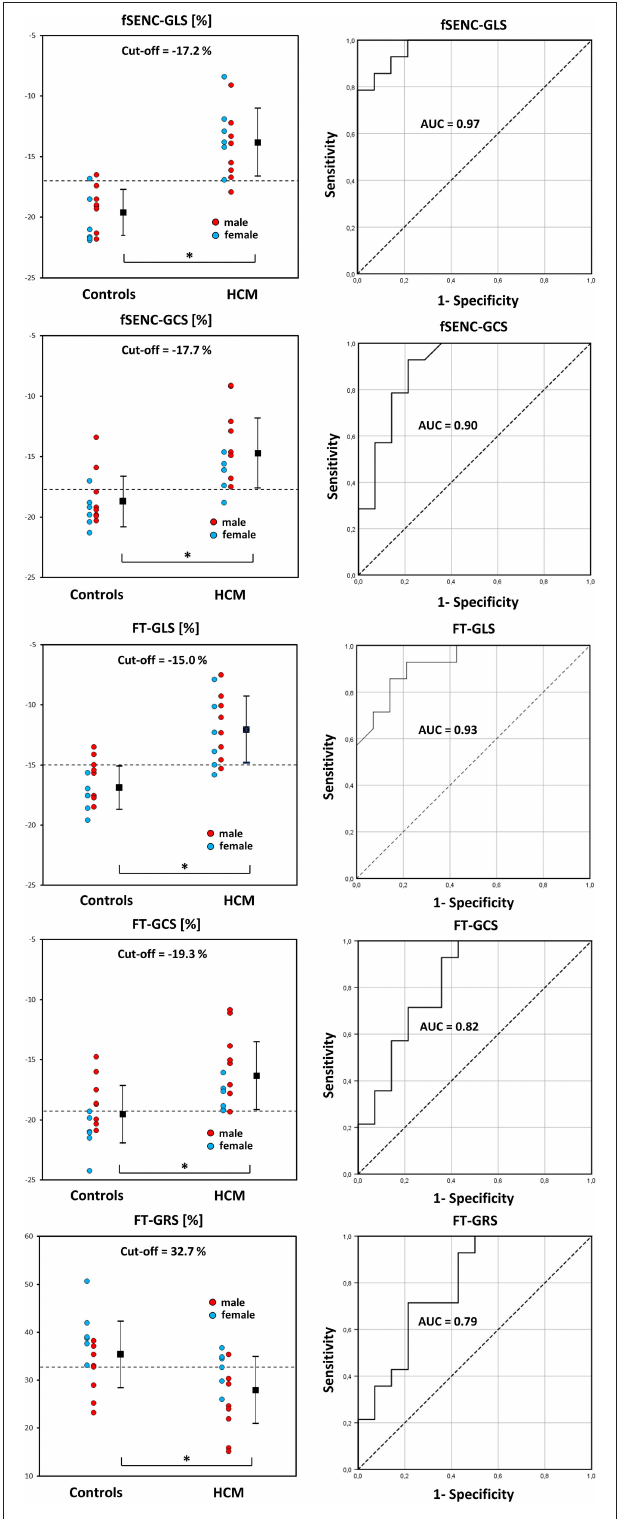
FIGURE 9 | DOT-charts with cut-off values (left) and ROC-curves with AUC values (right) for FT-GLS, FT-GCS and FT-GRS as well as for fSENC-GLS and fSENC-GCS. Mean ± standard deviation is indicated by bar graphs. GLS, global longitudinal strain; HCM, hypertrophic cardiomyopathy. *statistically significant with p <